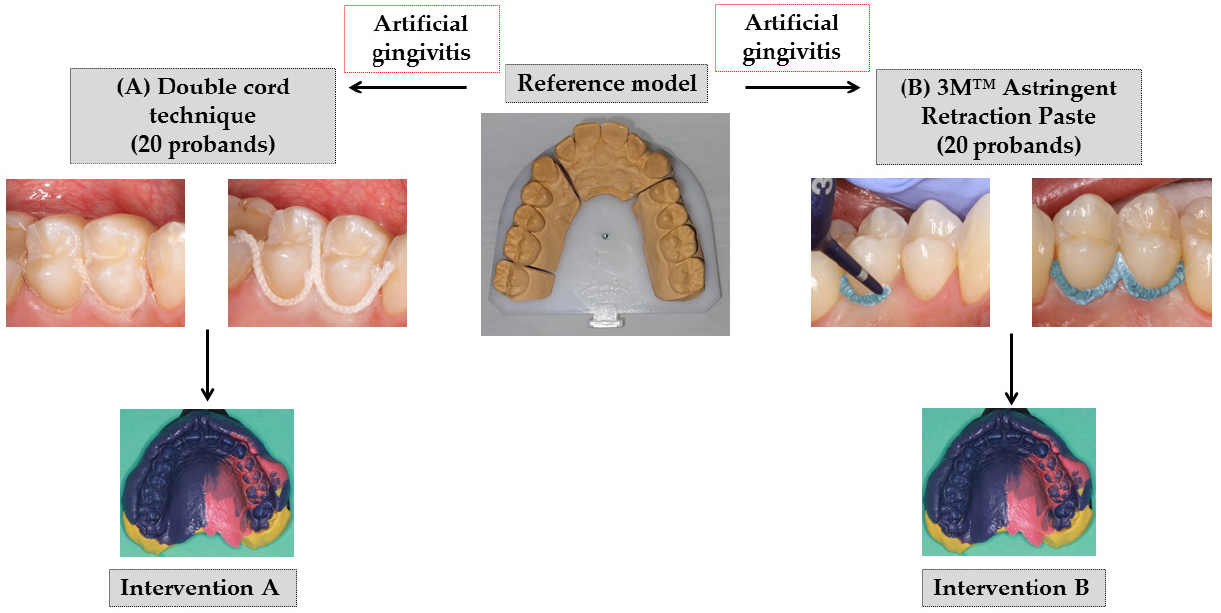
Figure 1. Design of the randomized clinical trial (RCT) with the two interventions: ( A ) double-cord technique or ( B ) 3M™ Astringent Retraction Paste for gingival displacement prior to conventional impression making.